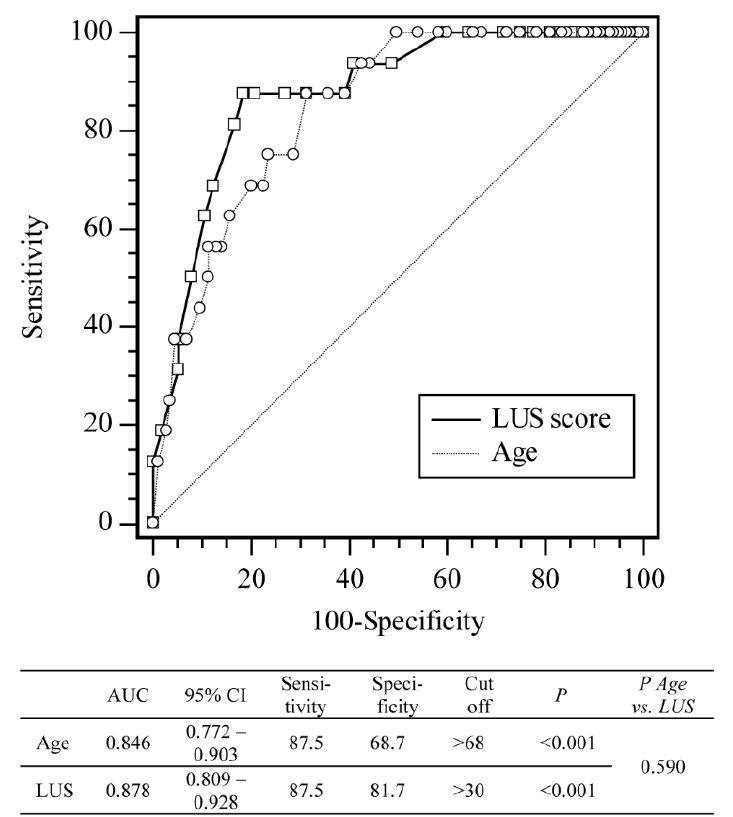
Figure 3. Receiver operating curve analysis of sensitivity, specificity, and cut-off values for LUS score and age according to the probability of a negative outcome (death).